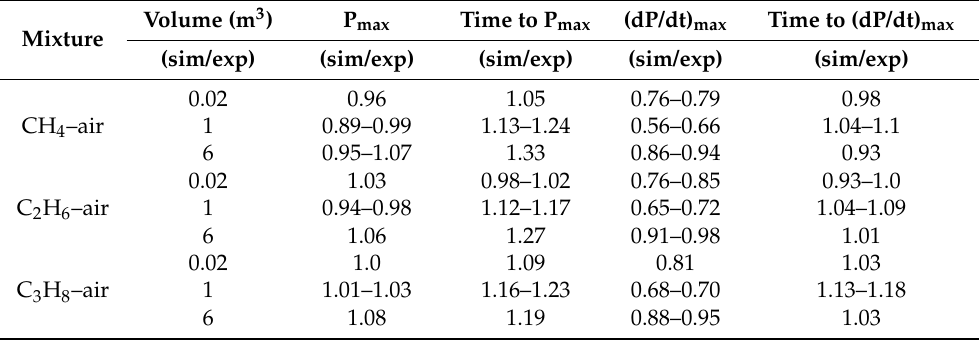
Table 3. Ratios of simulated, “sim” (non-adiabatic) and experimental “exp” parameters describing combustion in considered